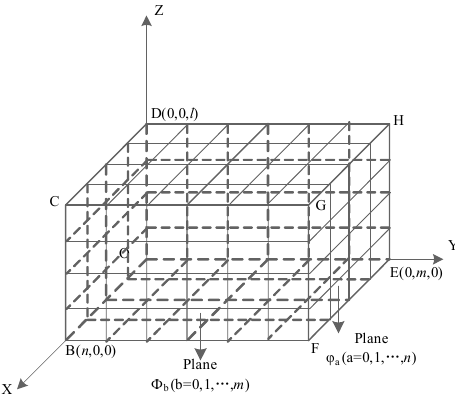
Figure 2. The division of the planning space. The name the plane perpendicular to the Y -axis in “Plane Φ b ( b = 0,1, . . . , m ) ”, and the name of the plane perpendicular to the X -axis in “Plane ϕ a ( a = 0,1, . . . , n ) ”.